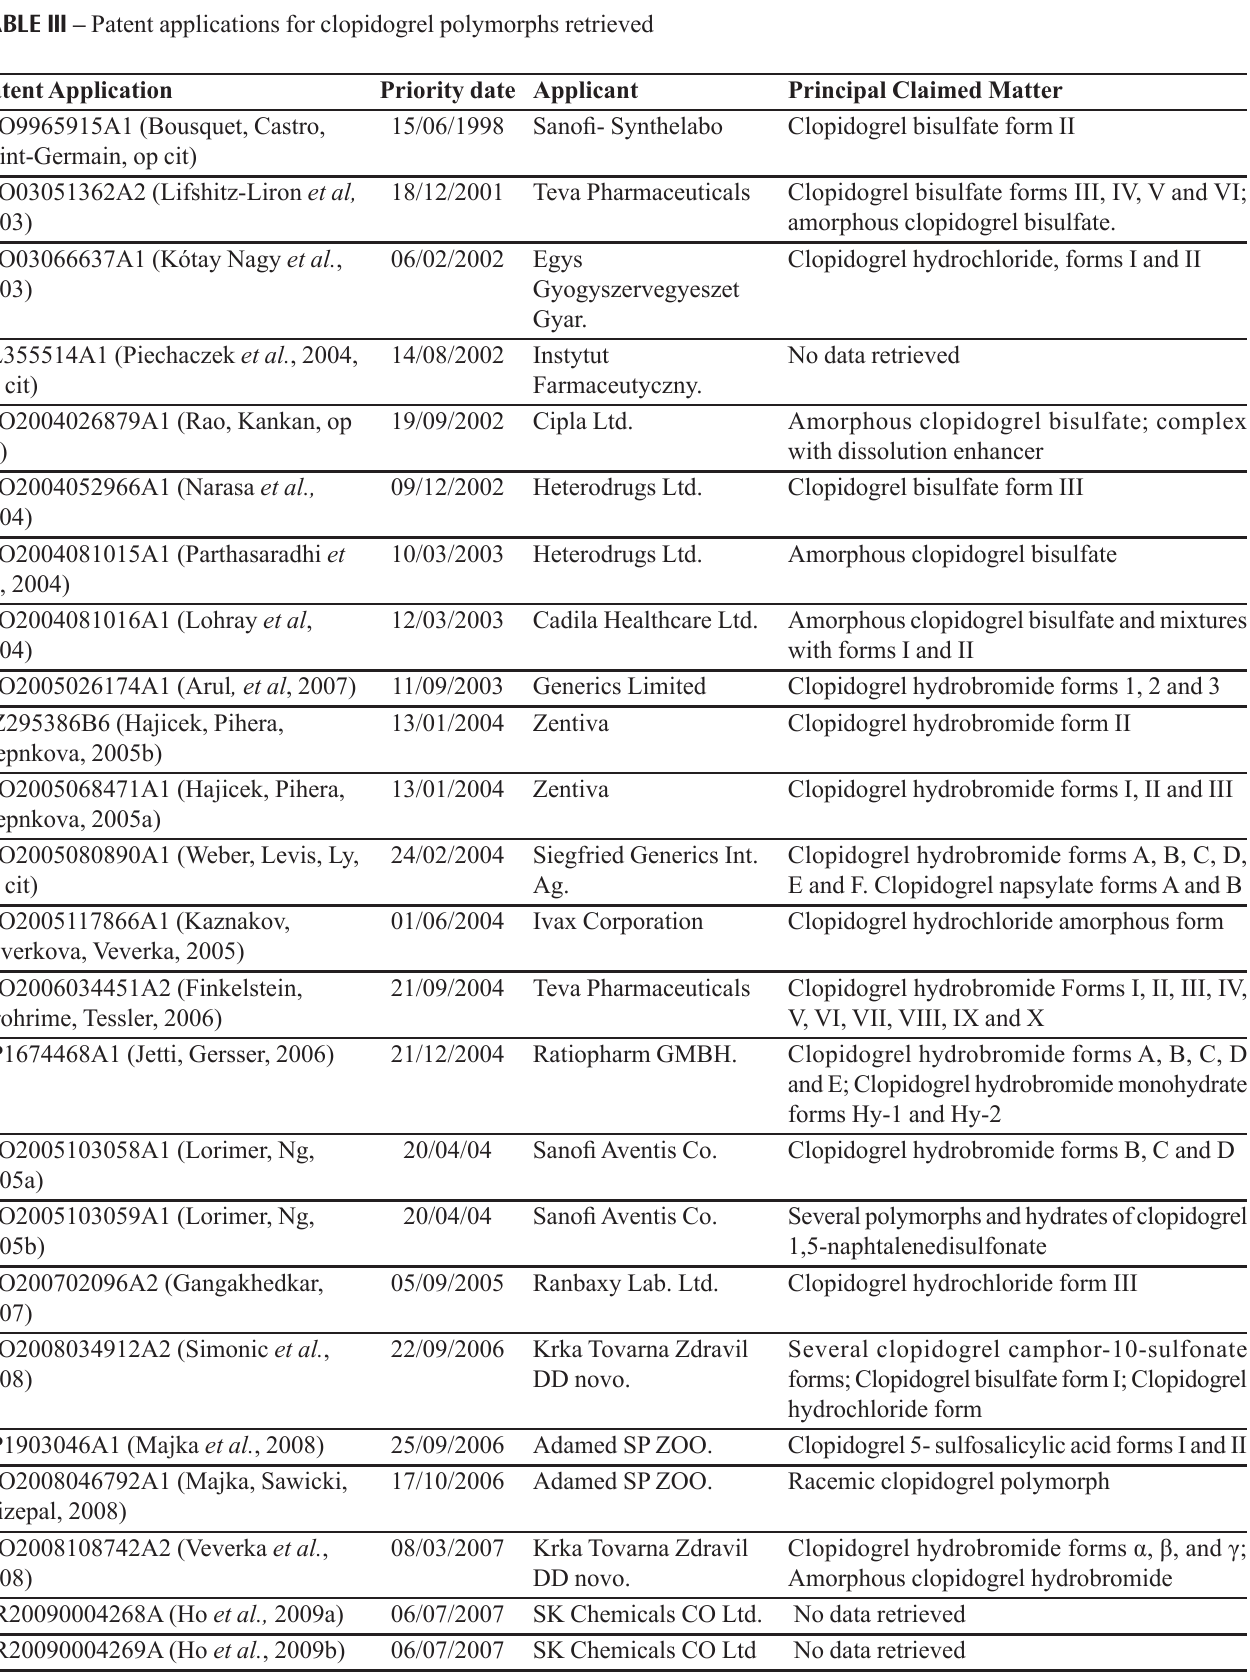
TABLE III – Patent applications for clopidogrel polymorphs